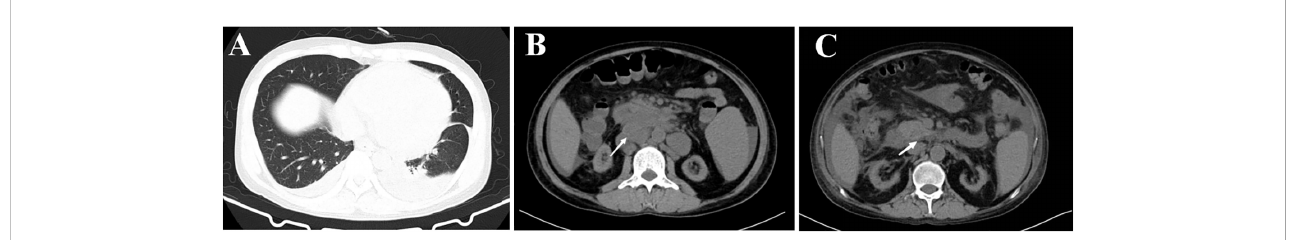
FIGURE 1 CT image results in lung and abdomen of the patient. (A) CT image of lung infection with Talaromyces marneffei . (B) CT image of abdomen, lymphadenopathy in the retroperitoneum and mesenteric root, and hepatosplenomegaly, the largest of which is 31×25 mm (white arrow). (C) CT image of abdomen, lymphadenopathy in the retroperitoneum and mesenteric root, and hepatosplenomegaly are improved, the largest of which becomes normal (white